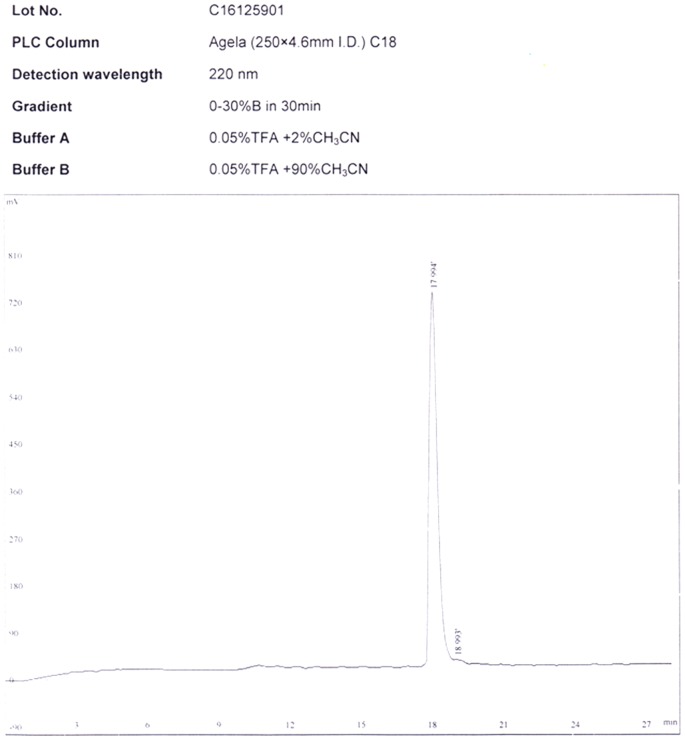
HPLC result.HPLC result of RRL showed there only one peak, indicating the good quality of synthesis.